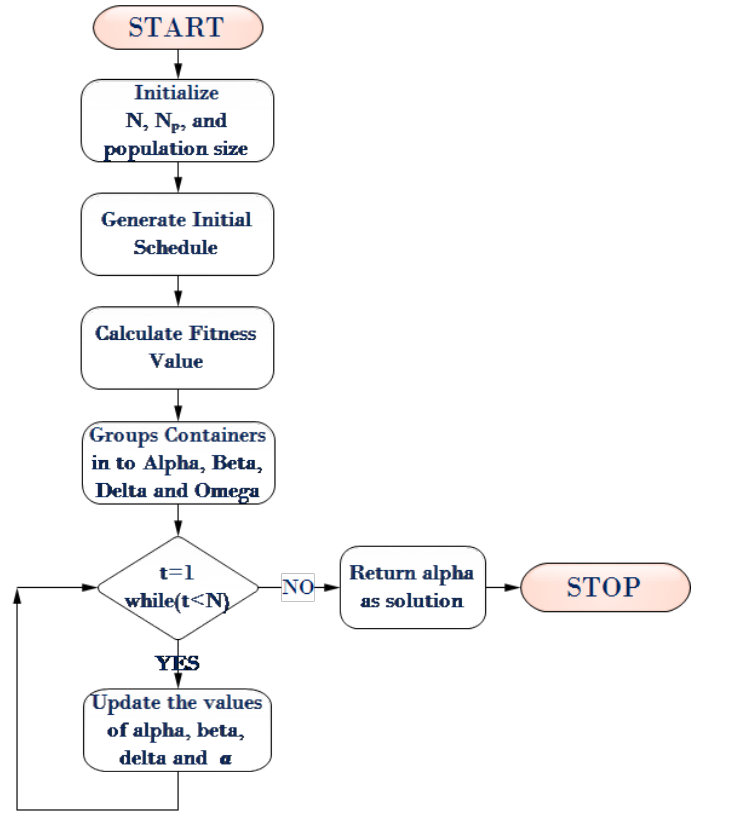
Figure 7. Flowchart of the Proposed